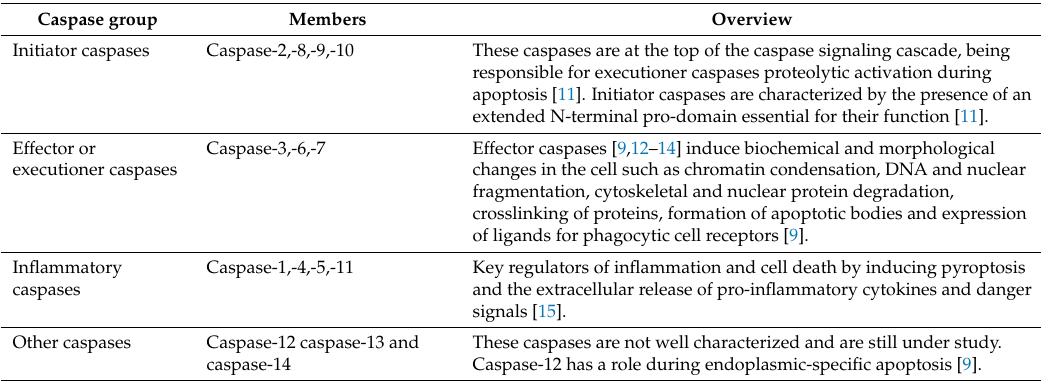
Table 3. Caspases